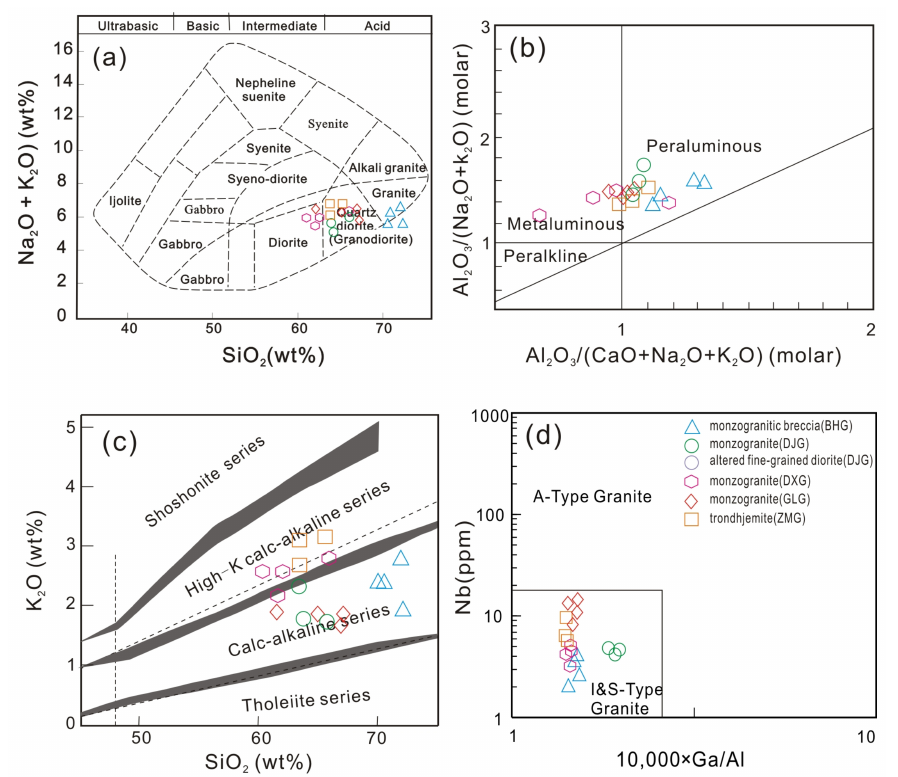
Figure 7. ( a ) The chemical classification and nomenclature of plutonic rocks using the total alkalis versus silica (TAS) diagram [53]; ( b ) A/NK vs. A/CNK [54]; ( c ) K 2 O vs. SiO 2 [55]; ( d ) diagrams of Nb vs. 10,000 × Ga/Al of A-type granites from I- and S-type granites [56].